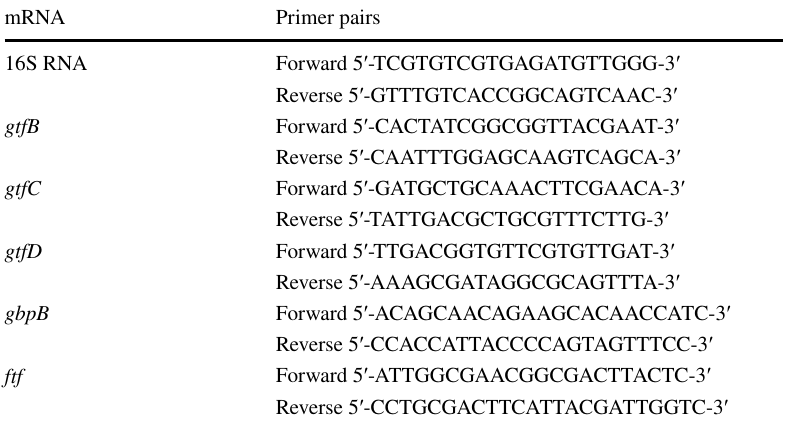
sequences of relevant genes designed for quantitative